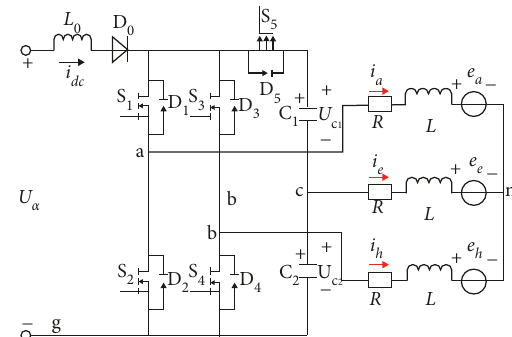
Figure 2: Equivalent and operational circuit of the BLDC